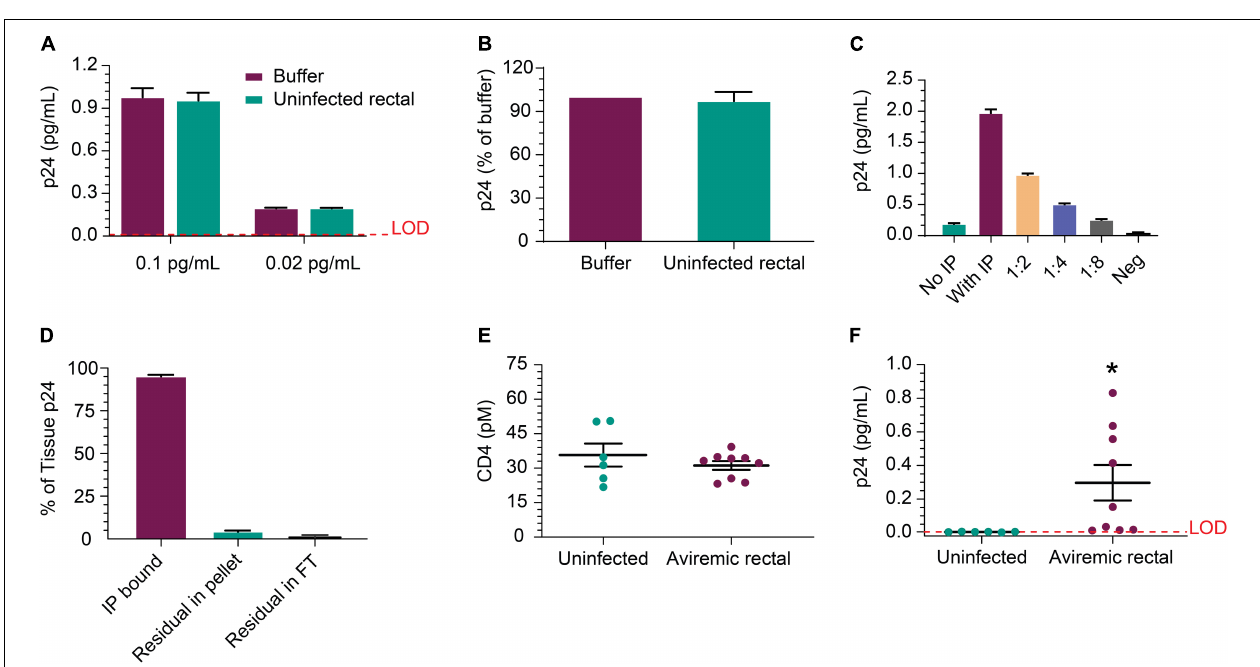
FIGURE 4 | Development of human CD4 protein assay and application to rectal biopsy lysate characterization. (A) Signal in the ELISA was proportional to the CD4 protein level over a broad standard curve concentration range from 0 to 250 pM. (B) Assay specificity was shown with CD4 signal linearly decreasing following rectal biopsy sample lysate serial dilution. (C) Twenty-4 h of biopsy soaking while mixing in lysis buffer yields complete CD4 protein release from rectal biopsy.